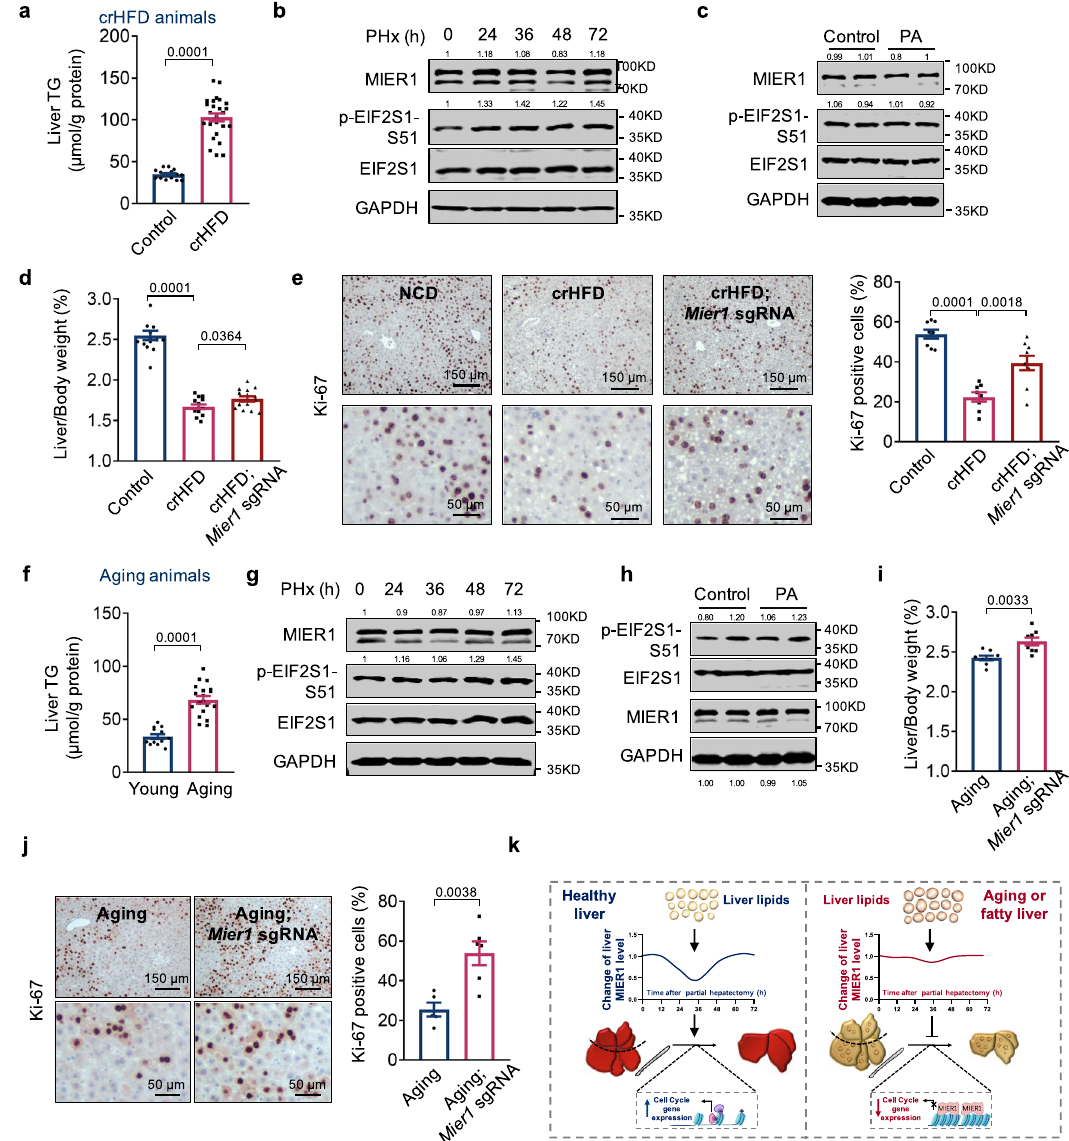
Fig. 7 | Animals with chronic liver steatosis show dysregulated MIER1 expres- sionandimprovedliverregenerationuponMIER1depletion.a LiverTGanalysis inanimalsfedwithNCDorHFDfor8weeks(crHFD)(Control, n =15;crHFD, n =25). b ImmunoblotsofliverMIER1andEIF2S1phosphorylationincrHFDanimalsbefore or after hepatectomy. c Immunoblots of MIER1 and EIF2S1 phosphorylation in primaryhepatocytesfromcrHFDanimalsafterPA(0.5mM)treatmentfor10h.The liver/bodyweightratio(%)( d )( n =14),andliverKi-67immunostaining( e )(Control, n =8; crHFD, n =8; crHFD; Mier1 sgRNA, n =9) in NCD, crHFD, and crHFD; Mier1 sgRNA animals at 48h after hepatectomy. f Liver TG analysis in young (~8 weeks ’ old) and aging (~12 months ’ old) animals (Young, n =12; Aging, n =19). g Immunoblots of liver MIER1 and EIF2S1 phosphorylation in aging animals before or after hepatectomy. h Immunoblots of MIER1 and EIF2S1 phosphorylation in primary hepatocytes from aging animals after PA (0.5mM) treatment for 10h. The liver/body weight ratio (%) ( i ) ( n =8), and liver Ki-67 immunostaining ( j ) (Young,